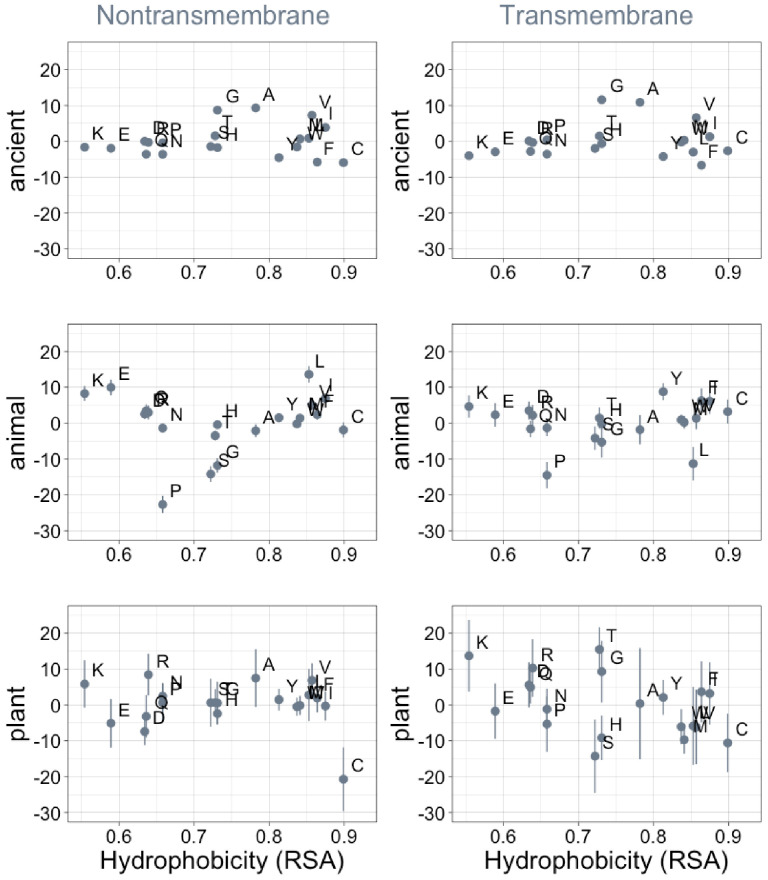
Phylostratigraphy slopes are not significantly correlated with hydrophobicity, as measured by 1-relative solvent accessibility (RSA) (Tien et al., 2013).Phylostratigraphy slopes are in units of percentage points of composition per billion years. Lines indicate the standard errors on the slopes. ‘Ancient’ refers to pfams older than 2101 MY (nontransmembrane and transmembrane, Spearman’s p = 0.7 and 0.5), calculated over all lineages, whereas ‘animal’ (nontransmembrane and transmembrane, Spearman’s p = 0.8 and 0.6) and ‘plant’ (nontransmembrane and transmembrane, Spearman’s p = 0.9 and 0.05) slopes are calculated over pfams appearing after the divergence between the animal/fungi and plant lineages, 1496 MY, assessed in only animal or only plant instances.